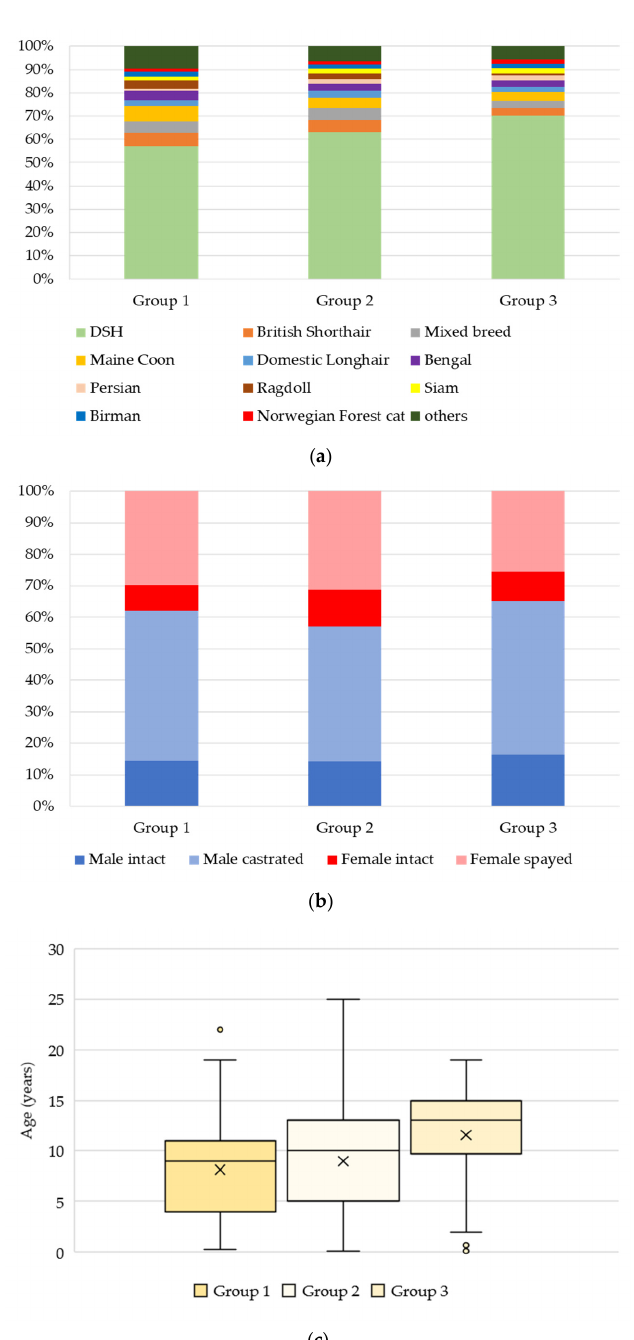
Figure 3. Comparison of the signalment from group 1 (fTLI decreased <8 µg/L), group 2 (fTLI reference interval 8–88 µg/L), and group 3 (fTLI increased >88 µg/L). ( a ): Breeds: The most common breed in all groups was Domestic Shorthair. The percentages of the other breeds were comparable in all three groups. ( b ): Sex: Percentages of intact or castrated males and intact or spayed females were similar in the groups. ( c ): Age: Cats with decreased serum fTLI concentrations had the lowest (nine years), and cats with increased serum fTLI concentrations had the highest median age (13 years). Outlier were included as circles.